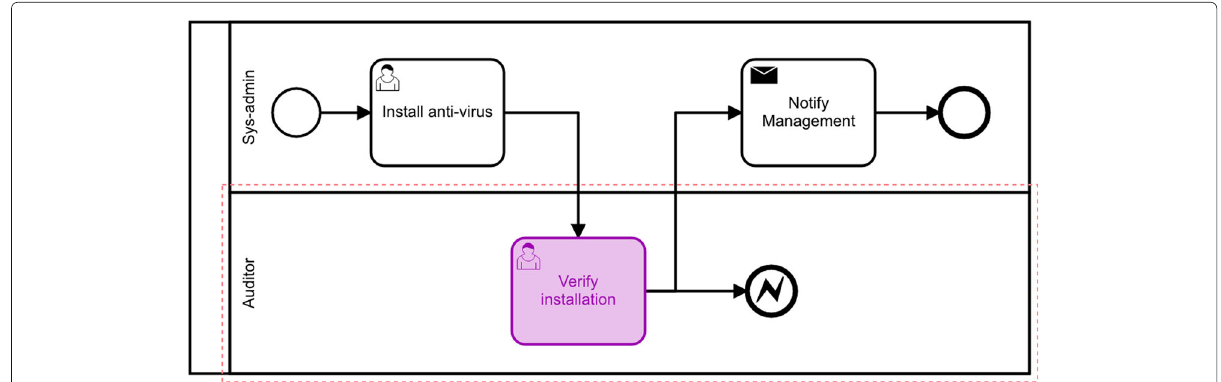
Fig. 10 Requirement for validating action has been